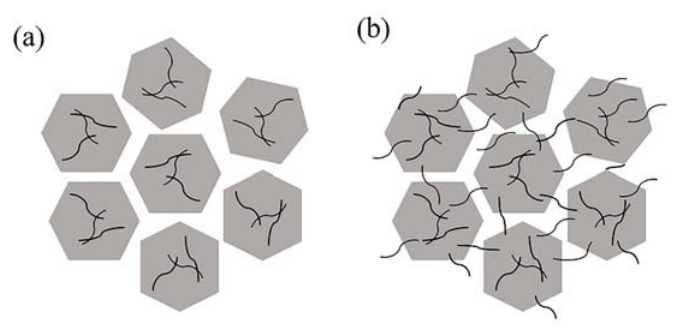
Figure 7. Schematic diagram of the effect of different BN@xCNT hybrid fillers on the heat transferring: